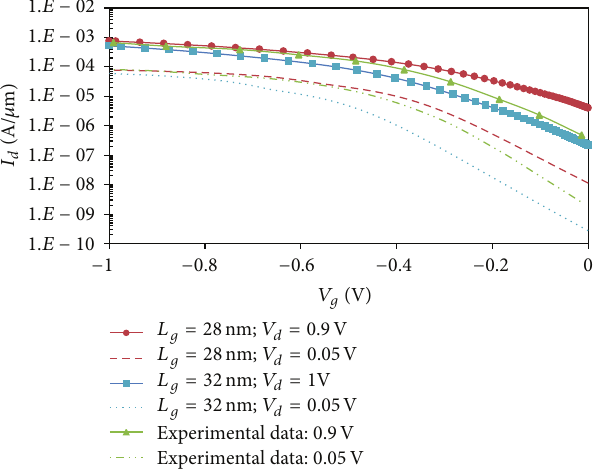
Figure 2: 𝐼 𝑑 - 𝑉 𝑔 characteristics of simulated devices and comparison with experimental data in [17].